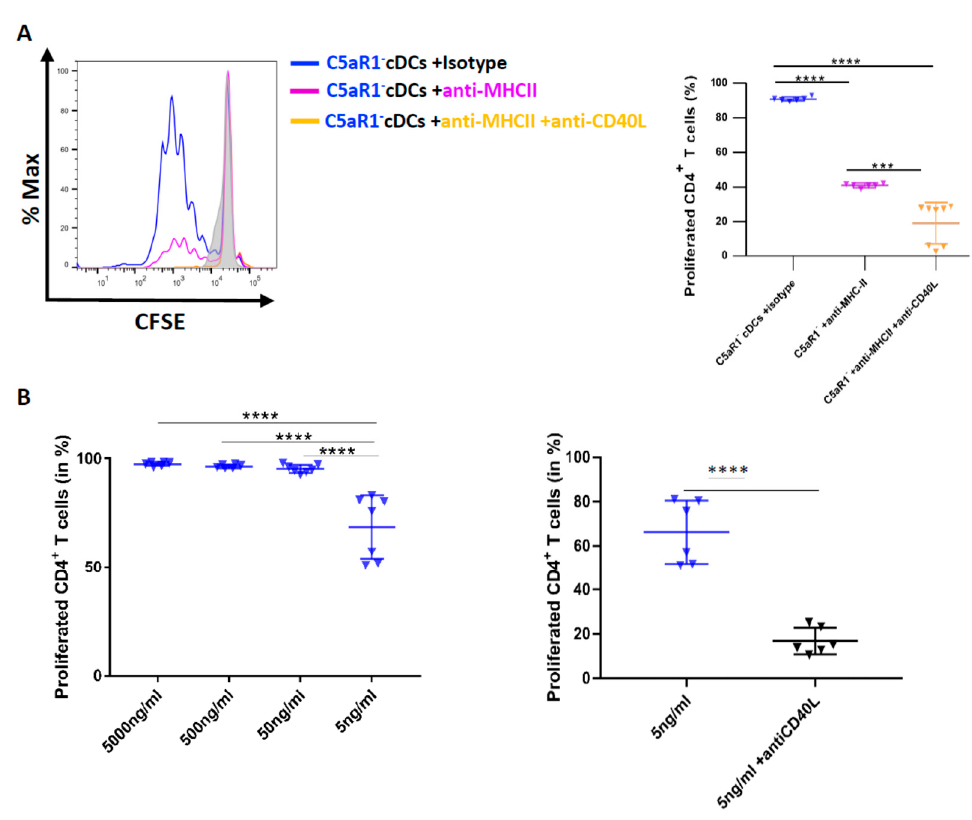
Figure 7. The e ff ect of MHC-II targeting on C5aR1 − cDC-driven T cell proliferation in response to CD40L neutralization. ( A ) Histogram (left) showing the impact of MHC-II (10 pg / mL) blockade on T cell proliferation in C5aR1 − cells in the presence or absence of CD40L blockade; the grey histogram shows the signal obtained from T cell directly after CFSE labeling. The graph on the right-hand side shows the quantitative evaluation of MHC-II ± CD40L blockade. Values shown are the mean ± SEM; n = 6–8 per group. Data were analyzed by ANOVA, followed by Tukey post-hoc test; * indicates significant di ff erences between the treatment groups; *** p < 0.001 and **** p < 0.0001. ( B ) Impact of CD40L targeting on T cell proliferation when the antigen concentration is limited. WT mice were treated once with HDM (100 µ g) i.t. C5aR1 − cDCs from WT mice were FACS-purified from lung tissue 24 h after the treatment. C5aR1 − cDCs were co-cultured with CFSE-labeled OVA-specific TCR tg CD4 + T cells in the presence of di ff erent concentrations of OVA 323–339 peptide (5 µ g / mL, 500 ng / mL, 50 ng / mL, 20 ng / mL and 5 ng / mL) and GM-CSF (20 ng / mL). Left panel: frequency of proliferated T cells in response to di ff erent concentrations of OVA 323–339 peptide as mean ± SEM, n = 6–7. Data were analyzed by ANOVA, followed by Tukey post-hoc test; * indicates significant di ff erences between the di ff erent treatment groups, **** p < 0.0001; right panel: impact of CD40L targeting on C5aR1 − cDC-driven T cell proliferation in the presence of low OVA 323–339 peptide concentration, n = 6–7. Data were analyzed by unpaired t test; * indicates significant di ff erences between the two treatment groups; **** p <